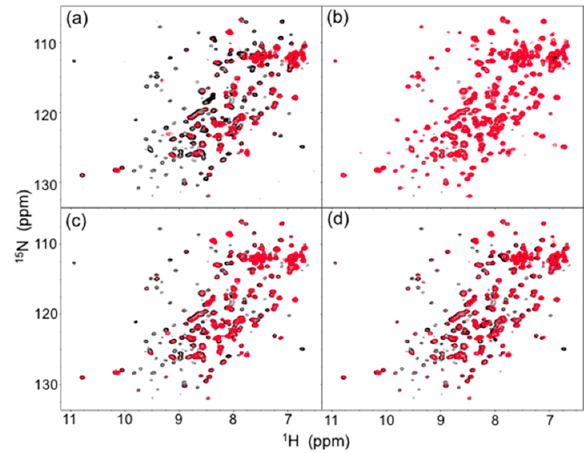
Figure 2. Comparison of 1 H- 15 N HSQC spectra (red) of uniformly 13 C, 15 N-labeled mouse IgG2b-Fc ( a ) in human serum and in the presence of ( b ) HSA, ( c ) human polyclonal IgG, and ( d ) the Fab fragment derived from human serum polyclonal IgG with the spectrum of the mouse IgG2b-Fc dissolved in 5 mM sodium phosphate buffer, pH 7.4, containing 150 mM NaCl. The spectra were recorded at 37 °C at 800 MHz.